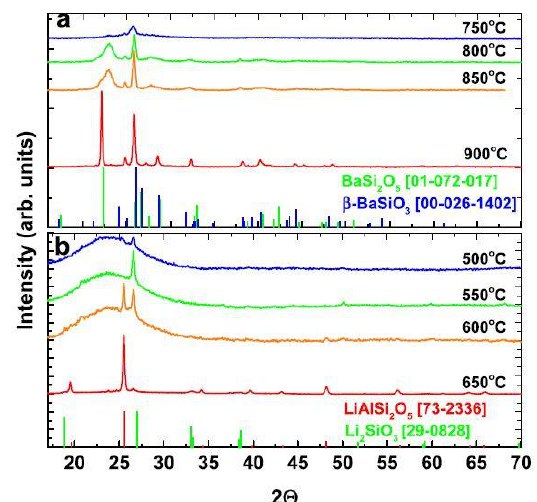
Figure 11. XRD patterns of DSB:Ce ( a ) and DSL:Ce ( b ) glasses annealed at different temperatures. Standard reference data are provided, as labeled (used with permission from Copyright Clearance Center/Elsevier, [47]).